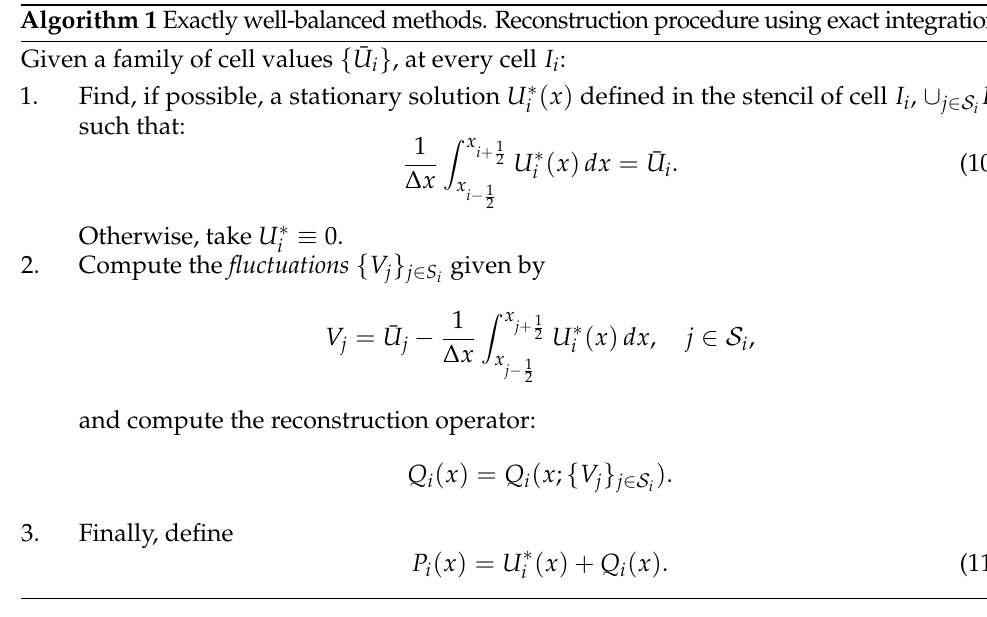
Algorithm 1 Exactly well-balanced methods. Reconstruction procedure using exact integration. Given a family of cell values { ¯ U i } , at every cell I i